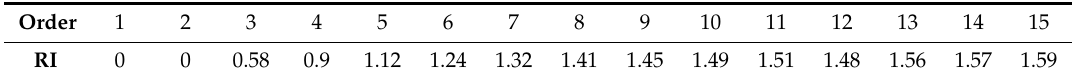
Table 2. Random index for di ff erent matrix orders